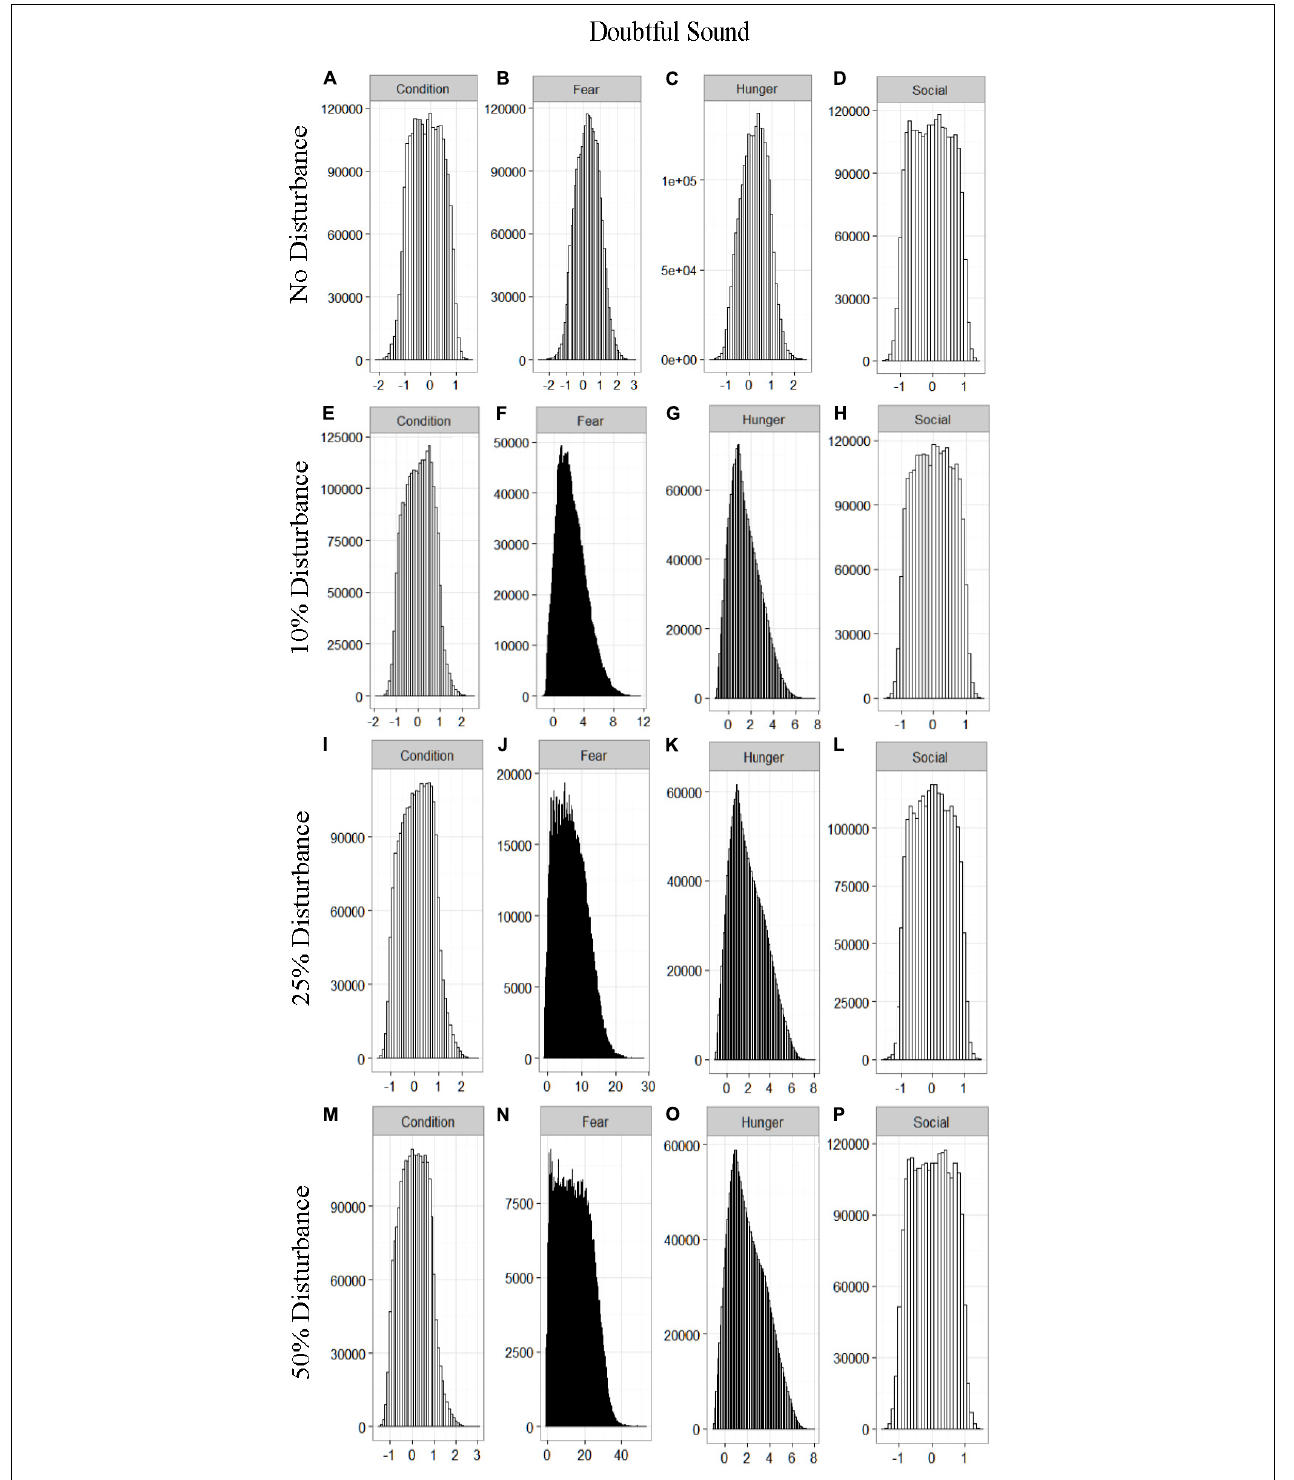
FIGURE 2 | The four motivational states of condition (A,E,I,M) , fear (B,F,J,N) , hunger (C,G,K,O) , and social need (D,H,L,P) for the simulated Doubtful Sound population under each of the four disturbance scenarios: no disturbance (A–D) and a 10% (E–H) , 25% (I–L) , or 50% (M–P) chance of an individual being disturbed when in the area used by whale-watching vessels. The y -axis is the cumulative count over all simulations, while the x -axis is a unit-less measure of individual motivation. Motivation is centered at zero (i.e., indifference) and can take on negative values to indicate a lack of incentive (i.e., satisfaction) and positive values to indicate strong incentive (i.e., discontent) (New et al.,